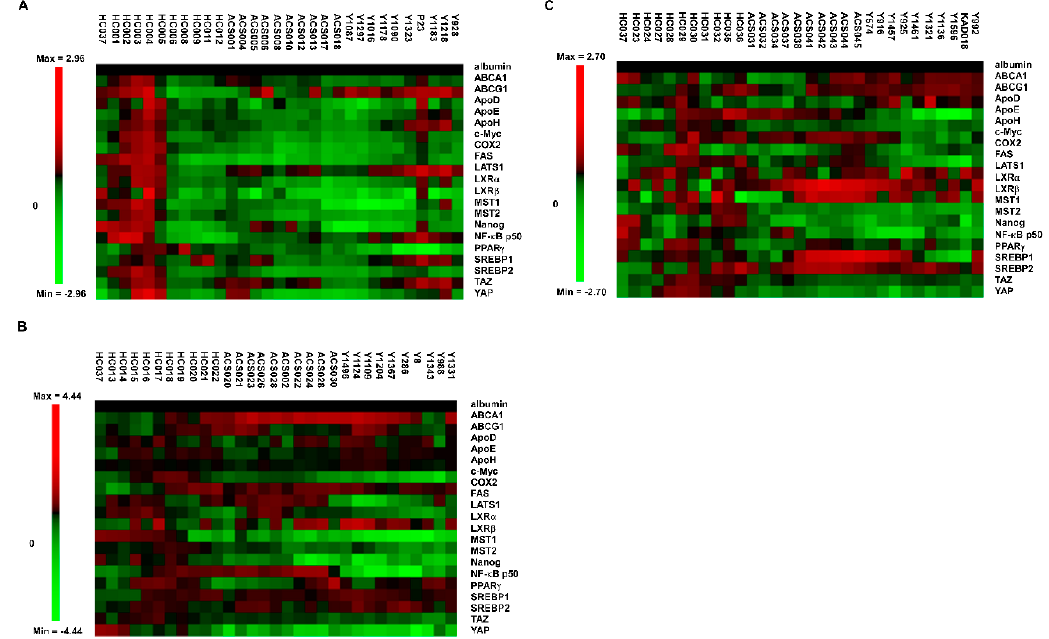
Figure 3. Micro-Western Array analysis of serum protein expression profile in HC, ACS and AD participants. The 31 health control samples, 30 ACS samples and 30 AD samples were separated into three MWA gel loading for analysis as gel 1 ( A ), gel 2 ( B ) and gel 3 ( C ). The average expression level of a specific protein in HC group was used as standard for that protein and was set to be one for relative protein abundance. Expression of proteins in all participants was normalized to the standard level and was converted to log 2 value for heatmap demonstration. Red color indicated an increase while green color represented an decrease as compared to the standard. The albumin was used as loading control.